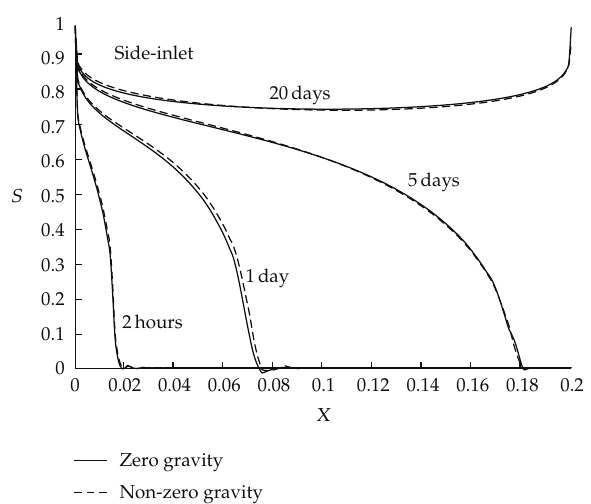
Figure 4: Comparison between considering and neglecting gravity e ff ect on water saturation for the side- inlet case, at z (cid:8) 0 . 15m.